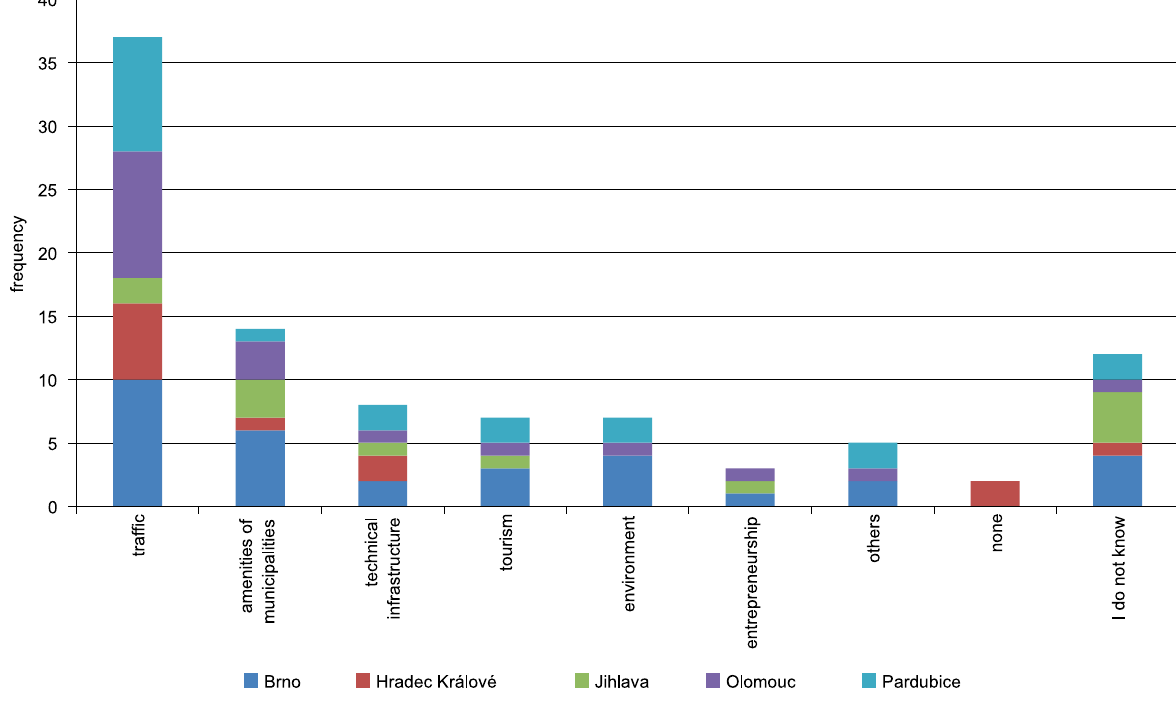
Fig. 4. The themes of the municipal projects that the municipalities would like to include in the ITI/IAdP. Source: Survey of 69 municipalities in the hinterland of the selected core cities, GaREP,